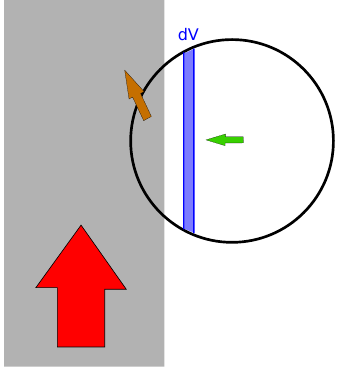
Figure 1. Sketch of the model. The jet’s ram pressure (red arrow) ablates the material that has entered the jet (brown arrow). The differential volume d V entering the jet in a differential time interval d t is given by the blue area. The green arrow marks the (horizontal) motion of the cloud with respect to the jet